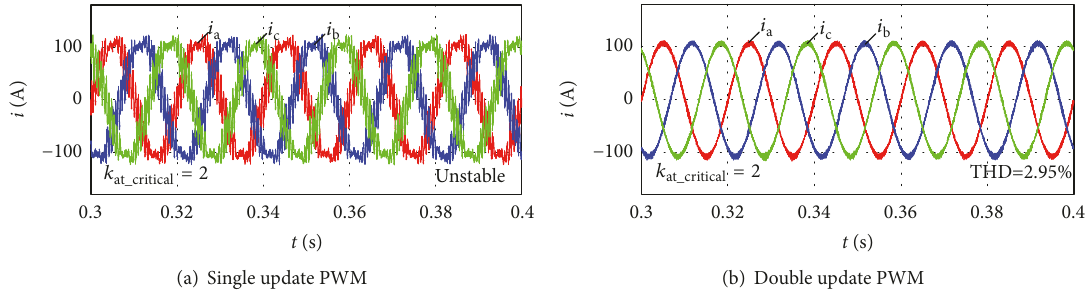
Figure 15: Steady state simulation waveforms of grid currents with 𝑘